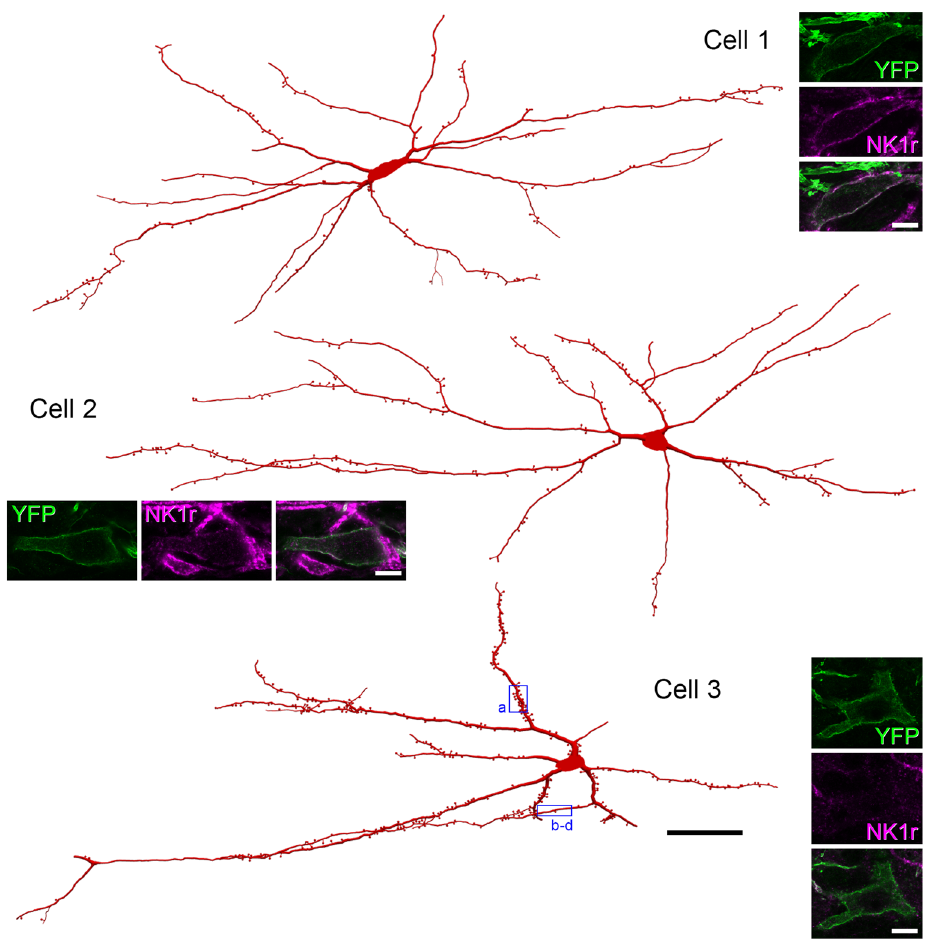
Figure 9. Neurolucida reconstructions of Phox2a cells from horizontal sections of Phox2a::Cre;Rosa26 LSL-ChR2-EYFP mice. The drawings show the cell bodies and dendritic trees of 3 YFP-positive cells. Note that although the locations of all dendritic spines are shown, these are represented in a standardised way that does not indicate spine shape. Insets show confocal scans through the cell body of each neuron. YFP is shown in green and NK1r-immunoreactivity in magenta. Cell 1 was classed as strongly NK1r-immunoreactive, Cell 2 as weakly NK1r-immunoreactive and Cell 3 as NK1r-negative. Boxes over Cell 3 show regions illustrated in Fig. 11. Scale bars: main figure = 100 μm; insets = 10 μm. Neurons were reconstructed with Neurolucida v2020.1.3 (https:// www. mbfbi oscie nce.